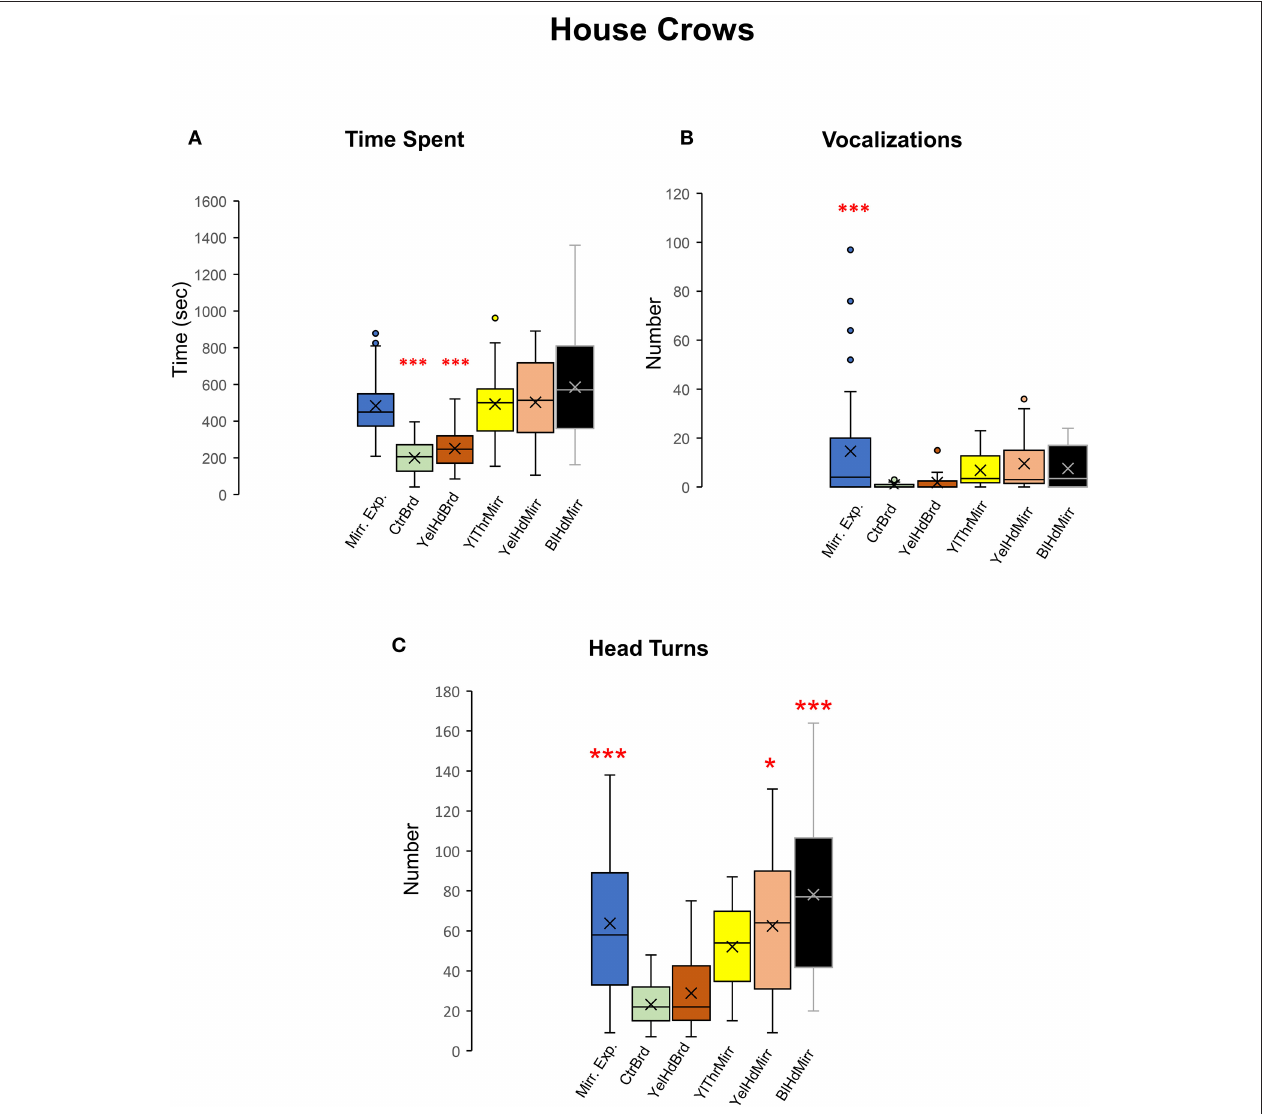
FIGURE 8 | Time spent facing the mirror, vocalizations, and head turns directed toward mirror images in house crows. (A) House crows ( n = 5) spent more time facing the mirror in the mirror exposure and mirror test conditions compared with that during the board test conditions. (B) They produced a significantly greater number of vocalizations while facing the mirror during the mirror exposure period compared with those during any of the test phase conditions ( Post-hoc Tukey test ***, P < 0.001). (C) There was a significant increase in contingency behaviors (head turns) during the mirror exposure trials, YelHdMirr and BlHdMirr conditions compared to trials when house crows were facing a board. There was a slight but non-significant increase in head turns in the YelThMirr condition ( post-hoc Tukey test *; P < 0.05; ***, P <